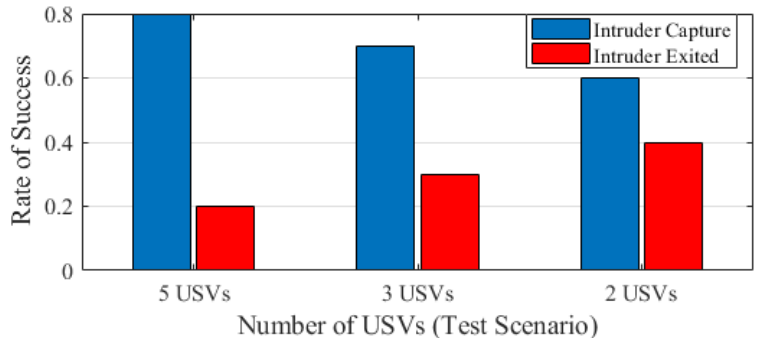
Figure 10. Success rate of USVs in capturing intruder (USV speed = 5 m · s − 1 , USV detection radius = 350 m, and intruder speed= 7.5 m · s − 1 ).